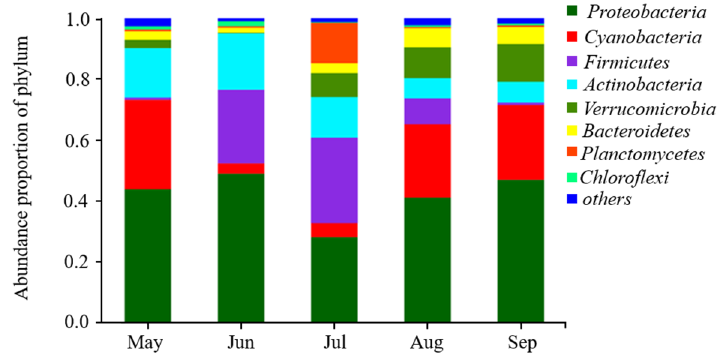
Figure 3. Taxonomic of microbial community in different months.